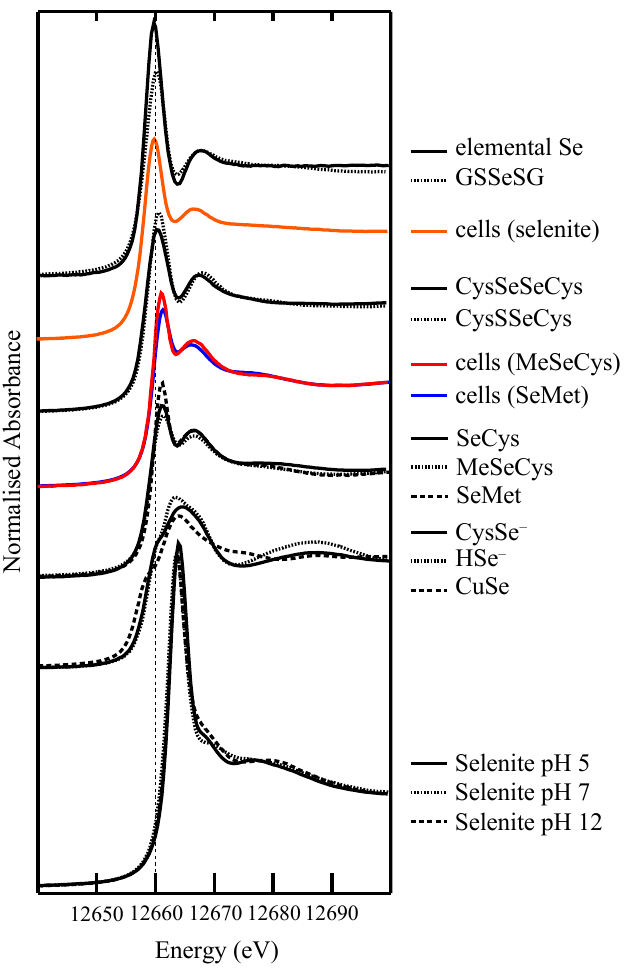
Figure 4. Library of Se K-edge X-ray absorption spectra of model selenium compounds used in the linear combination fitting of experimental spectra. XANES spectra of cells treated with 100 µM SeMet ( blue ), 100 µM MeSeCys ( red ) or 5 µM selenite ( orange ) are also shown for